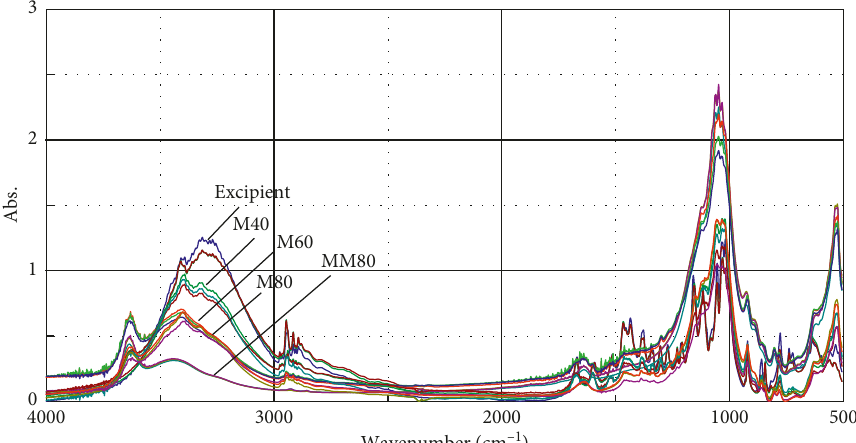
Figure 5: FT-IR spectra of mineralized mixture 80% (MM80), nonmineralized mixture 80% (M80), nonmineralized mixture 60% (M60), nonmineralized mixture 40% (M40), and